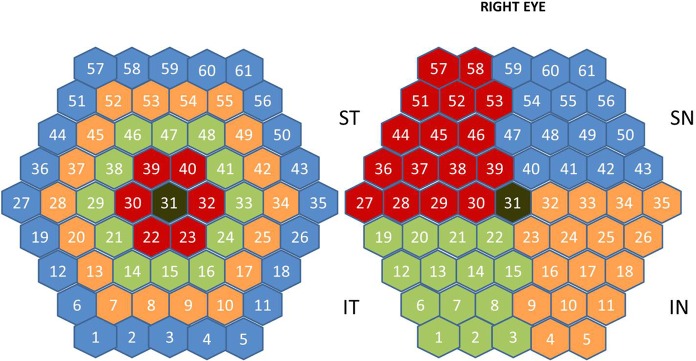
Stimulated visual field.In this figure the hexagons are not scaled with retinal eccentricity. (a) Definition of the rings (R1, … R5). (b) Definition for OD of the quadrants: ST, IT, SN, IN.